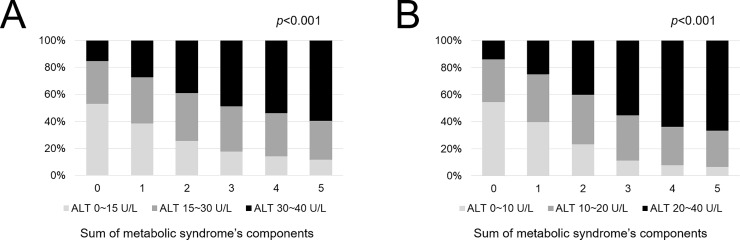
Differences of the ALT levels according to the sum of the metabolic syndrome scores: Male (A) and female (B). Abbreviation: ALT, alanine aminotransferase.